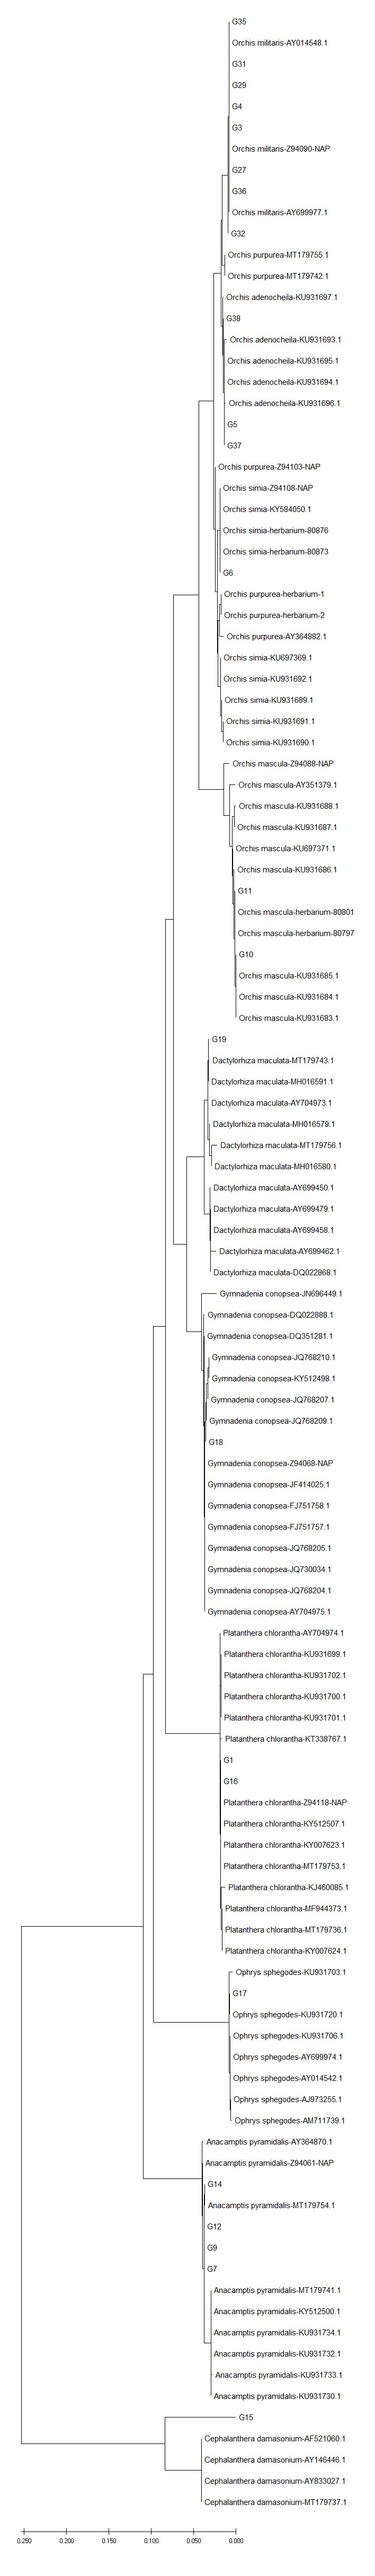
Neighbour-joining phylogenetic tree, based on ITS sequences of selected orchids. All sequences have been deposited in the Dryad Data Repository - doi: 10.5061/dryad.2ngf1vhmw